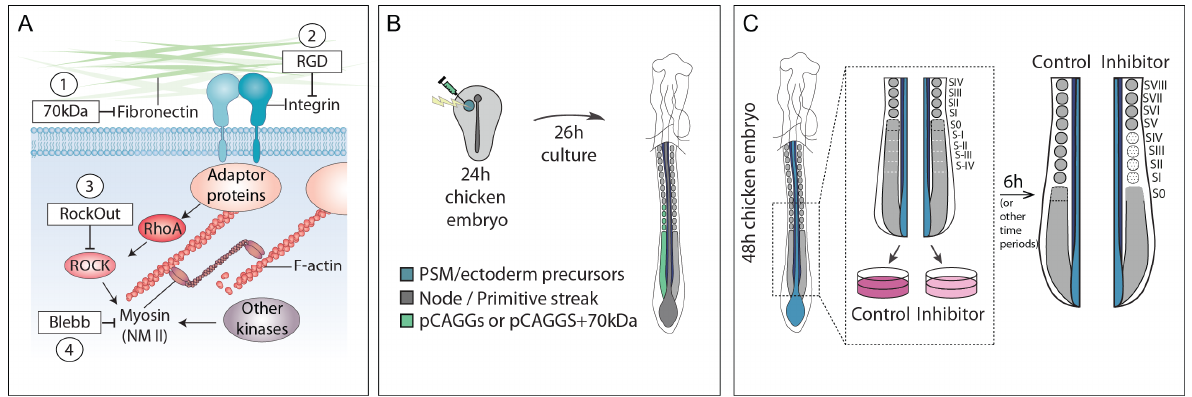
Figure 1. Experimental approaches to challenge the fibronectin–integrin–actomyosin communication axis. ( A ) Schematic representation of the four experimental treatments used: (1) expression of the 70 kDa N-terminal fragment of fibronectin impairs fibronectin matrix assembly; (2) addition of the linear RGD peptide to the culture medium competes with native fibronectin for integrin α 5 β 1 engagement, with effects on fibronectin matrix assembly and cell–fibronectin interactions; (3) addition of RockOut, a chemical inhibitor of ROCK I and II, enzymes involved in activating NM II downstream of integrins; and (4) addition of Blebbistatin, a chemical inhibitor that blocks NM II activation directly. ( B ) Electroporation strategy used for 70 kDa overexpression. PSM/ectoderm progenitors of primitive-streak stage embryos were electroporated on one side with either a pCAGGs GFP-expressing vector alone (pCAGGS), or co- electroporated with pCAGGs-GFP and a 70 kDa-expressing vector (70 kDa). Electroporated embryos were then cultured ex ovo for 26 h using the Early Chick culture method [53] , after which they were fixed. ( C ) Incubation of tissue explants with RGD or chemical inhibitors. HH11-14 embryos were collected, and the posterior region was isolated and bisected into two embryo half explants. Control (right or left) explants were cultured in medium only or medium containing DMSO, while experimental (left or right) explants were cultured in the presence of RGD, RockOut or Blebbistatin for the designated time. Both explant halves were fixed at the end of the culture period.